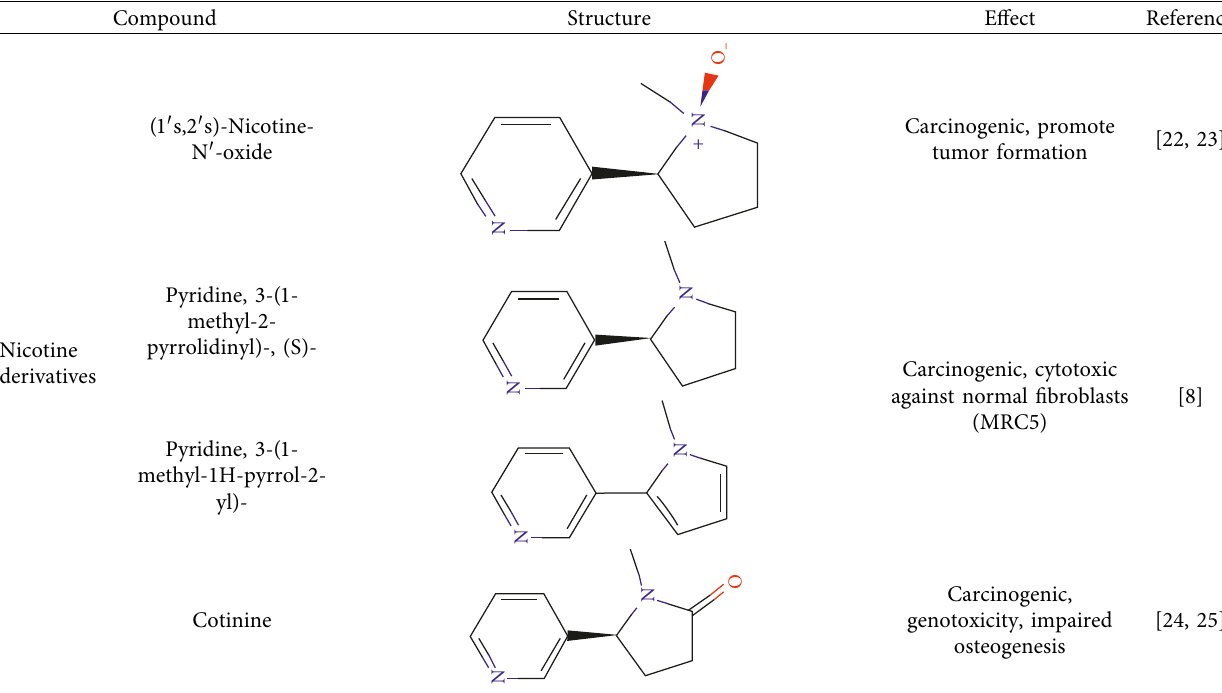
Table 5: Major compounds present in SLT samples, structure, and cytotoxic effects against normal cells. Compound Structure Effect